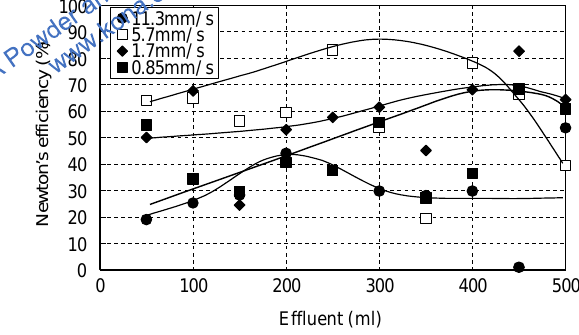
Newton’s efficiency as a function of effluent volume at various superficial velocity. Experimental conditions were pH4.0, KNO 3 concentration 10mM, and silica con- centration